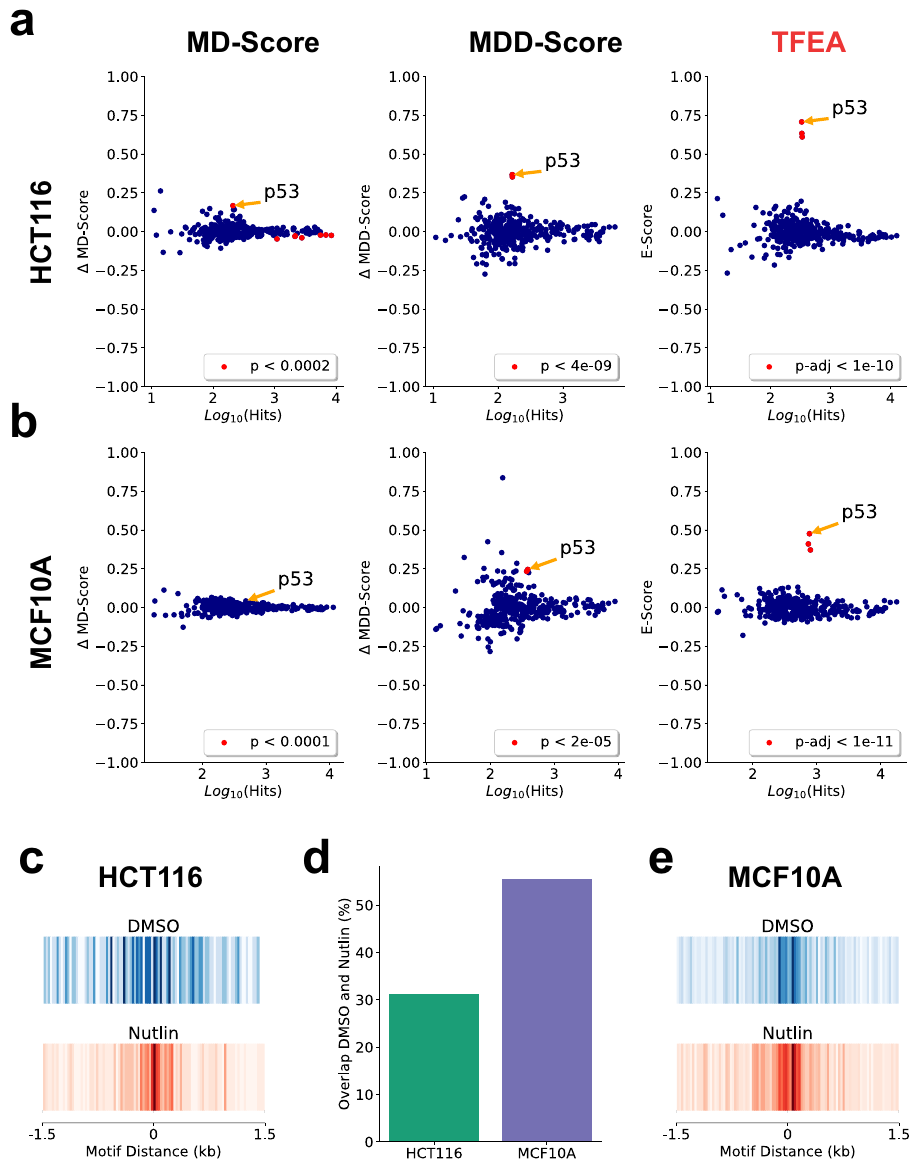
Fig. 3 TFEA improves the detection of p53 following Nutlin-3a treatment. a Application of the MD-Score, MDD-Score, and TFEA to GROSeq data in HCT116 cells with 1 h Nutlin-3a or DMSO treatment 1 . MA plots contrast a number of regions with motif ( x -axis) to the change in each score ( y -axis). Each dot is a distinct position-speci fi c scoring matrix (e.g., TF) with signi fi cant changes highlighted in red. Cutoffs determined by comparing untreated replicates (see Supplemental Fig. 12). b Application of the MD-Score, MDD-Score, and TFEA to PRO-Seq data in MCF10A cells with 1 h Nutlin-3a or DMSO treatment. c Motif displacement distribution plot of TP53 motif instances within 1.5 kb of all ROI in either DMSO (blue) or Nutlin-3a (red) (as a heatmap, darker indicates more motif instances). d Percentage overlap of TP53 motif instances within 150 bp of DMSO and Nutlin-3a ROIs. e Similar to ( c ) but in MCF10A cells. See Supplementary Data 1 for a complete list of accession numbers for data